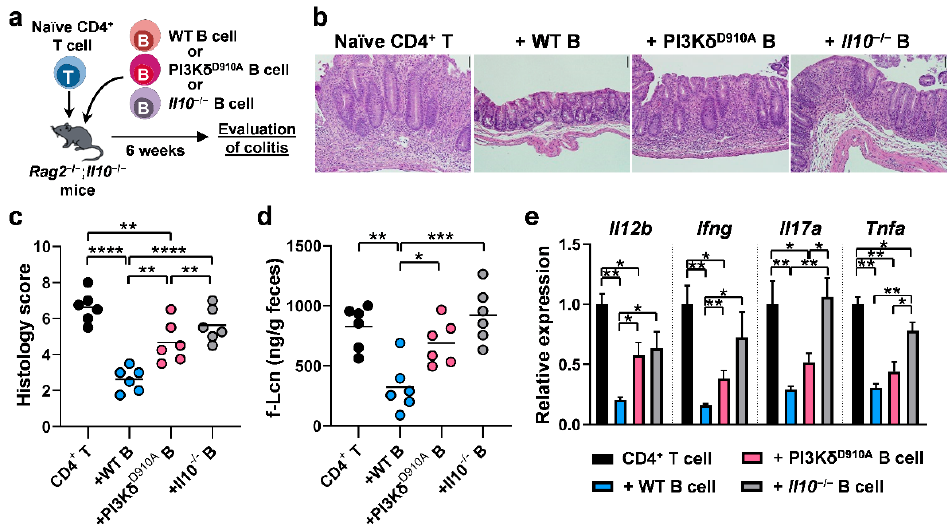
Figure 6. PI3K δ -signaling in B cells is required to confer protection against T cell-mediated colitis. ( a ) 5 × 10 5 splenic naïve CD4 + T cells were co-transferred intraperitoneally with or without 1 × 10 6 splenic B cells from WT, PI3K δ D910A , or Il10 − / − mice into Rag2 − / − ; Il10 − / − mice. The severity of colitis was evaluated 6 weeks after cell transfer. N = 6/group. ( b ) Representative images of H&E-stained cecum are shown. Scale bar represents 100 µm. ( c ) Histology scores are shown. Bar indicates the mean. ( d ) Lipocalin-2 in fecal supernatant (f-Lcn) was assessed by ELISA. Bar indicates the mean. ( e ) Expression of inflammatory cytokines in the distal colon was assessed by qPCR. Relative quantification was normalized to WT expression levels. Dunn’s multiple comparisons test following one-way ANOVA was used. * p < 0.05, ** p < 0.01, *** p < 0.001, **** p < 0.0001.